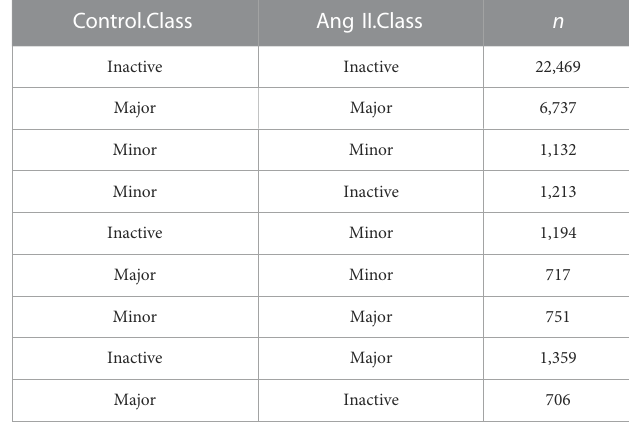
TABLE 2 State of isoform changing in Control and Ang II (Iso-Seq quanti fi cation). Control.Class